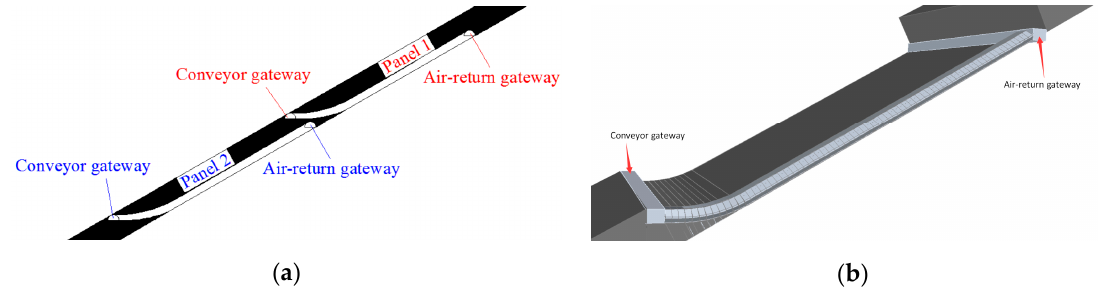
Figure 2. Longwall Mining with Split-level Gateways (LMSG). ( a ) LMSG for two adjacent panels; ( b ) Three-dimensional view of a LMSG panel.